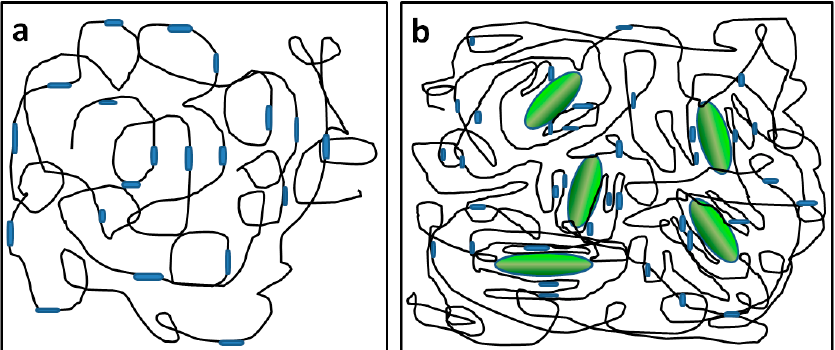
Figure 7. Schematic Illustration of Phase Separation in the: ( a ) WPU17 and ( b ) WPU17-SF films. The black and thin line, the blue and thick line, and the green ellipsoid represent soft segments of polyurethane, hard segments of polyurethane, and silk fibroin, respectively.